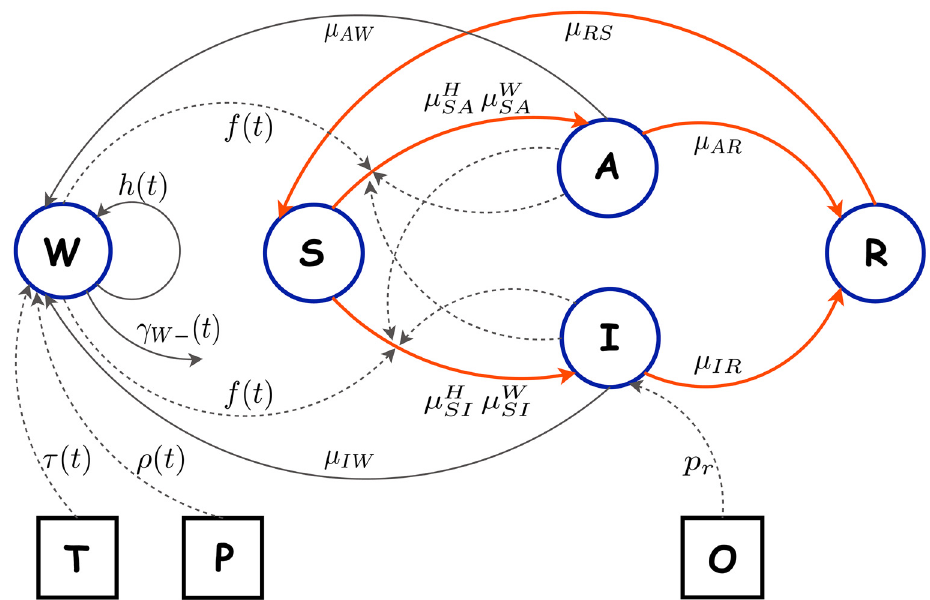
Fig 1. Compartmental model diagram. The unobserved compartmental SIRS model is linked to the observed data via a set of modeling assumptions. Blue boundary circular objects are the unobserved compartments of the SIRS model with the environmental compartment W . Black boundary square objects represent the collected observed data where O stands for the reported incidence and T and P stand for the environmental measurements of temperature and precipitation respectively. Temperature and precipitation affect the environmental reservoir W . The orange arrows indicate the movement of individuals between the human compartments. The grey arrows represent other processes in the model that do not directly involve the movement of humans between compartments. The actual bacterial movements such as human shedding and bacteria death are represented by solid grey lines. The other processes in the model such as the influence of temperature and precipitation on bacterial growth, the influence of aquatic reservoir and infected humans on transmission, and the relationship between the reported incidence O and the unobserved symptomatic incidence are represented by dashed grey lines. Please refer to S1 Text for more details on the model formulation, parametrization and relevant